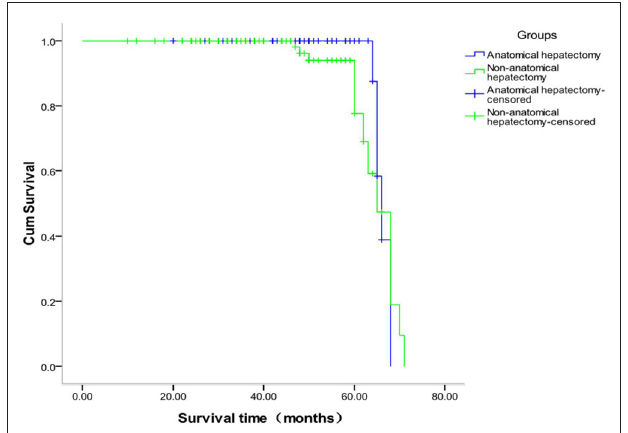
FIGURE 5 | Comparison of survival curves between the two groups with different surgical methods.